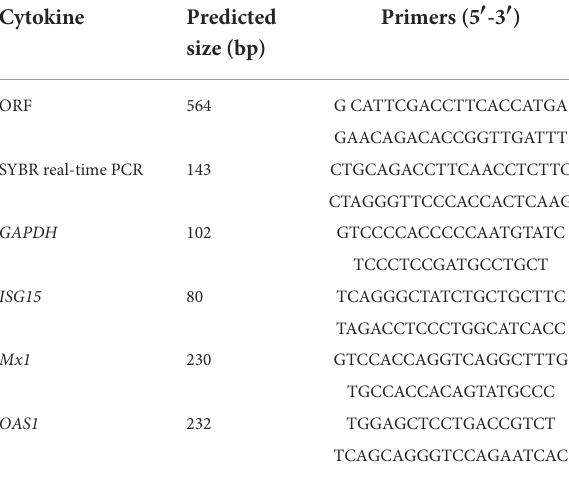
TABLE 1 Sequences of primers used in this